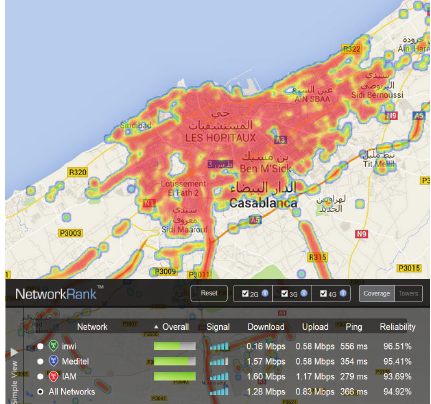
Figure 7: Cellular coverage maps, Casablanca